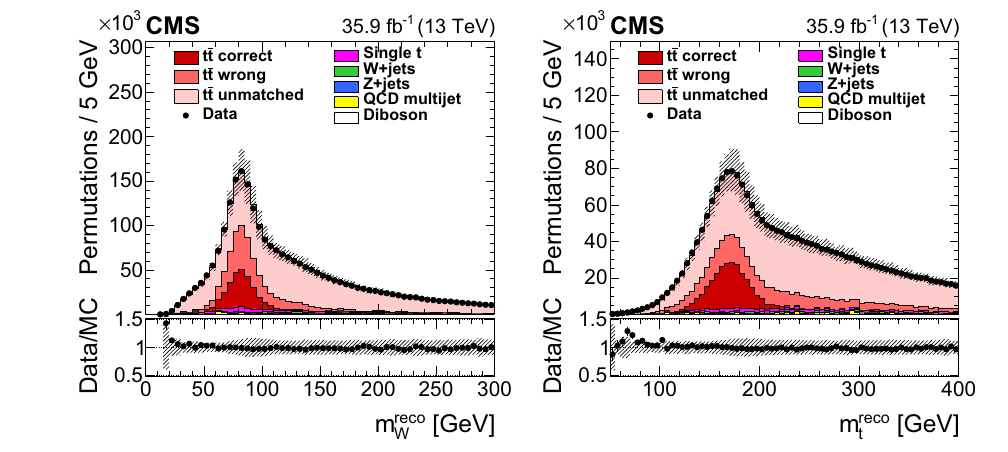
Fig. 1 Invariant mass m reco tical uncertainty on the data and the hatched bands show the systematic of the two untagged jets (left) and invari- W uncertainties considered in Sect. 5. The lower portion of each panel ant mass m reco t of the two untagged jets and one of the b-tagged jets shows the ratio of the yields between data and the simulation. The sim- (right) after the b tagging requirement. For the simulated tt events, the ulations are normalized to the integrated jet-parton assignments are classified as correct, wrong, and unmatched permutations as described in the text. The vertical bars show the statis-